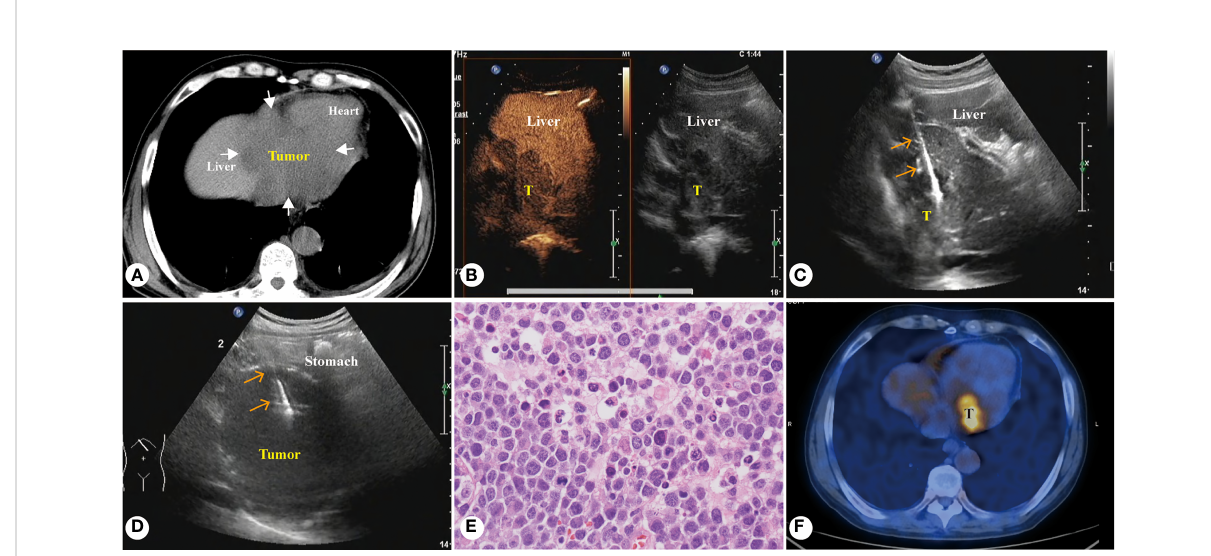
FIGURE 4 Sixty- fi ve-year-old male patient, diffuse large B-cell lymphoma (A) CT showed a huge homogeneous hypodense mass involving the left liver, gastric fundus and heart. (B) Enhanced ultrasound showed intrahepatic homogeneous low enhancement tumor. (C) PUS-CNB of the left liver tumor. (D) PUS-CNB of the gastric fundus tumor. (E) The microscopic features showed diffuse patches of large atypical lymphocytes with many eosinophilic cytoplasm (H&E, × 400). (F) Tumor was signi fi cantly reduced after fi ve courses of chemotherapy, but still